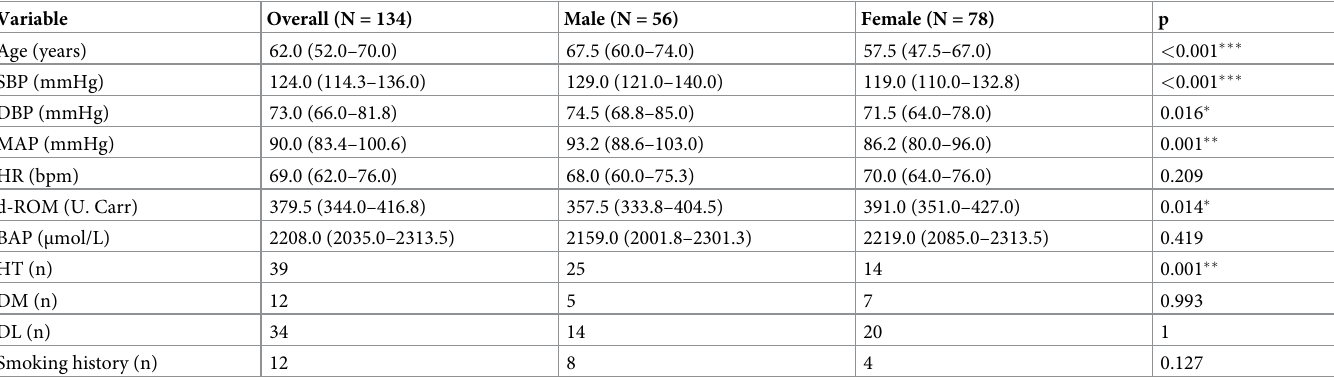
Table 1. Systemic characteristics of the normal-tension glaucoma